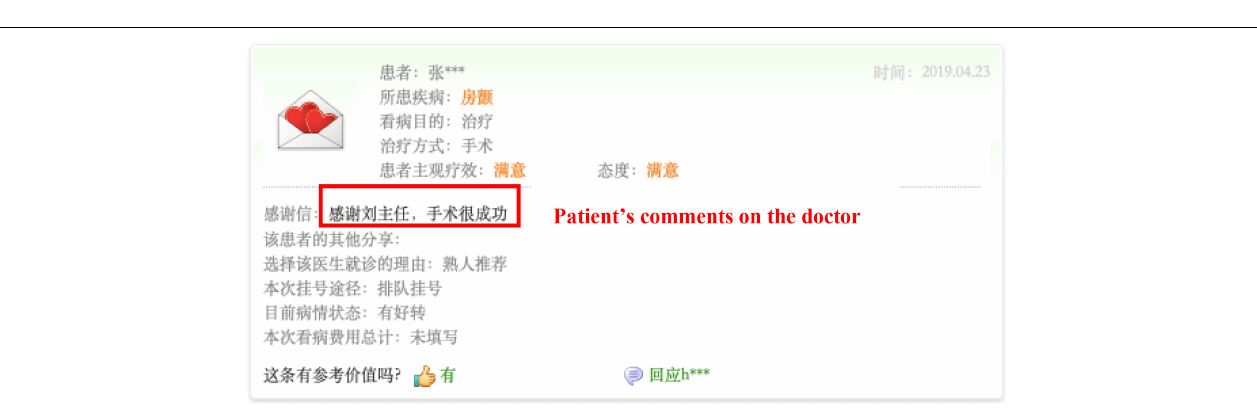
FIGURE 2 | Doctor’s information page.